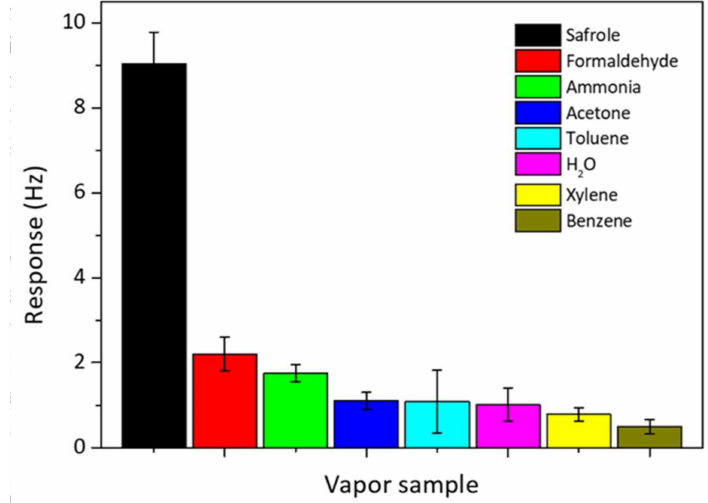
Figure 8. Selectivity of PAN nanofiber-coated QCM sensor over other analytes. The analyte concentration is predetermined at 1 mg/L.